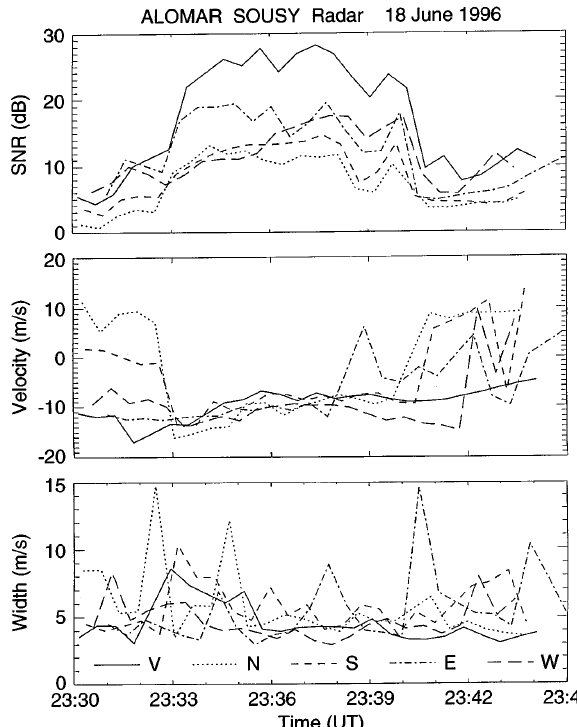
Fig. 5. The first three moments of spectra recorded between 23:30 and 23:45 UT in all five beam direction of the ALOMAR SOUSY radar. The line styles corresponding to the di(cid:128)erent beam directions, indicated in the lower panel , apply to all three